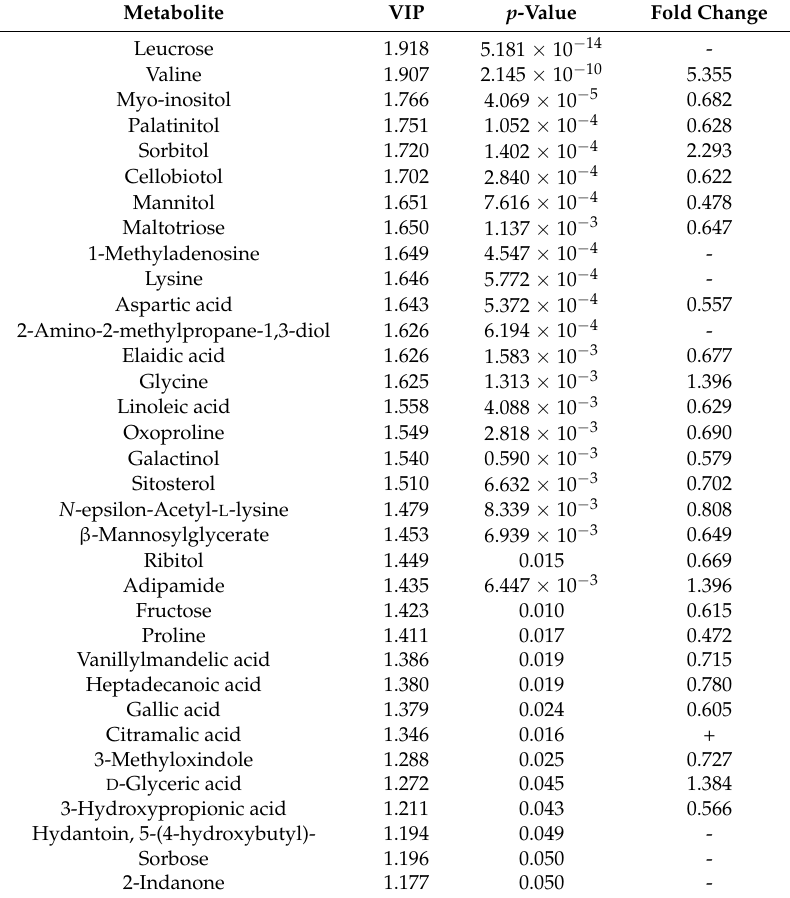
Table 2. Differential metabolites at 63 DAPs in DW and